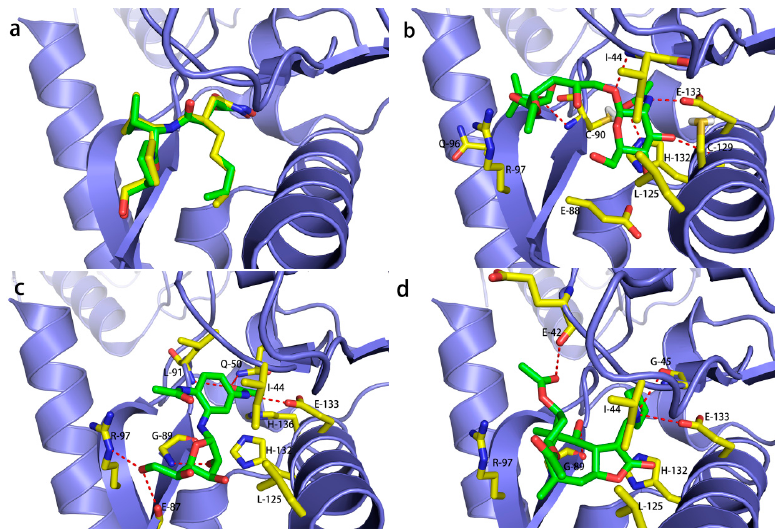
Figure 3. ( a ) Superposition of the crystal structure of Escherichia coli PDF-actinonin (colored in green) and its docked conformation (colored in yellow). The binding mode of three compounds in the E. coli PDF binding pocket: ( b ) ZINC12660672; ( c ) ZINC12652500 and ( d ) ZINC08740166. The red color bonds indicate the hydrogen bonds between compound and amino acids (colored by yellow).